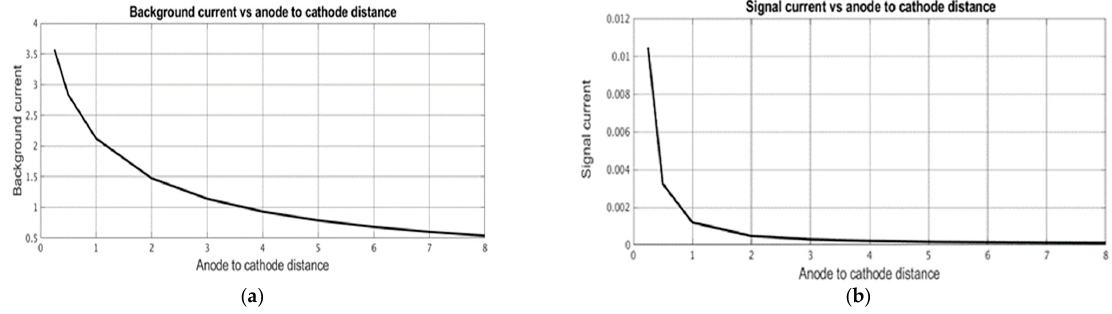
Figure 9. Dependence of ( a ) stationary background current and ( b ) signal current on the dimension- less distance between anode and cathode.